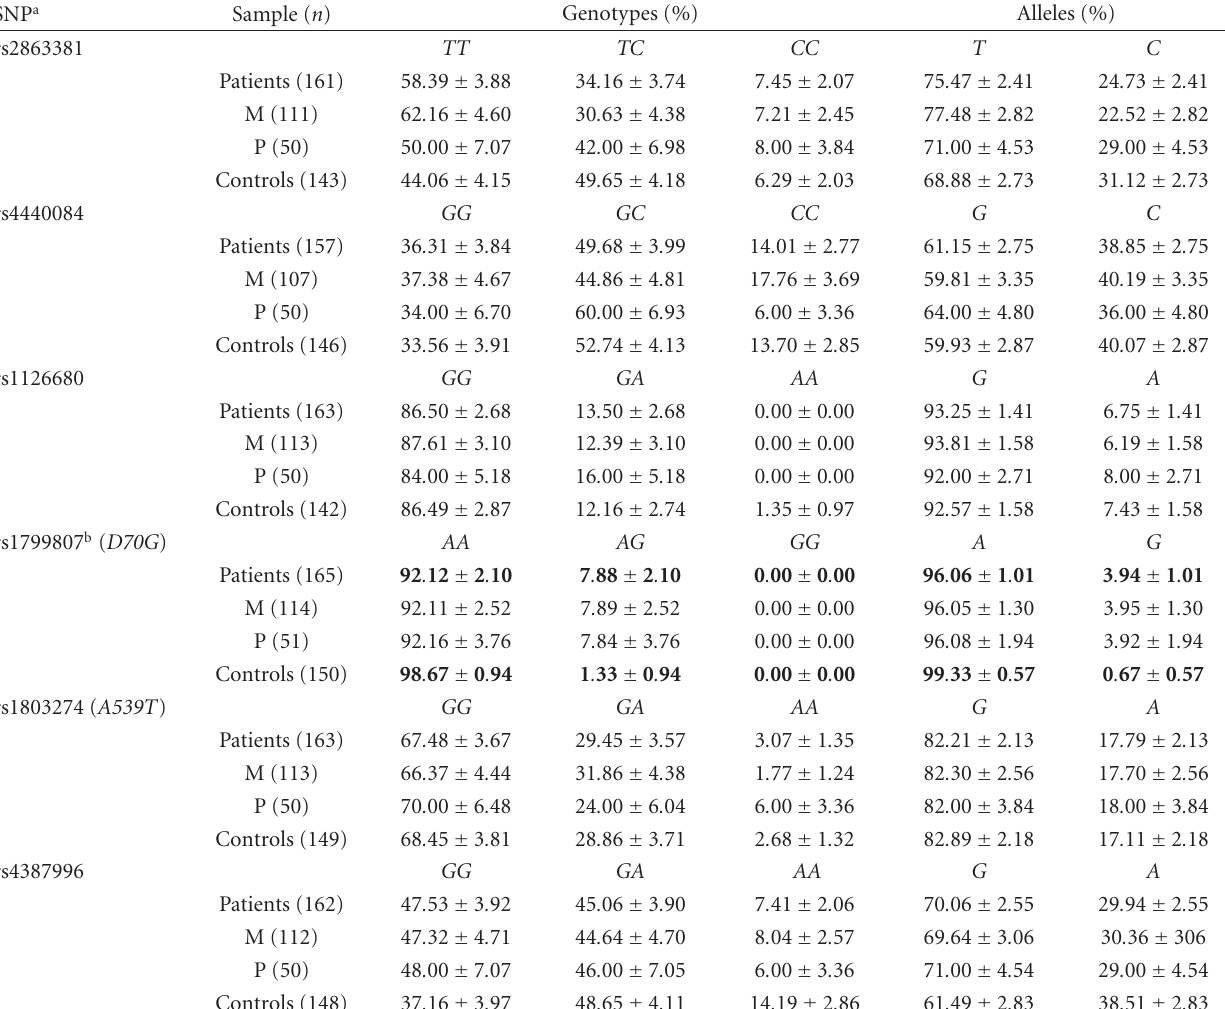
Table 1: Frequency distributions of allele and genotype data for the six studied SNPs in patients ( M : multibacillary; P : paucibacillary) and contact controls, as indicated by the nucleotide